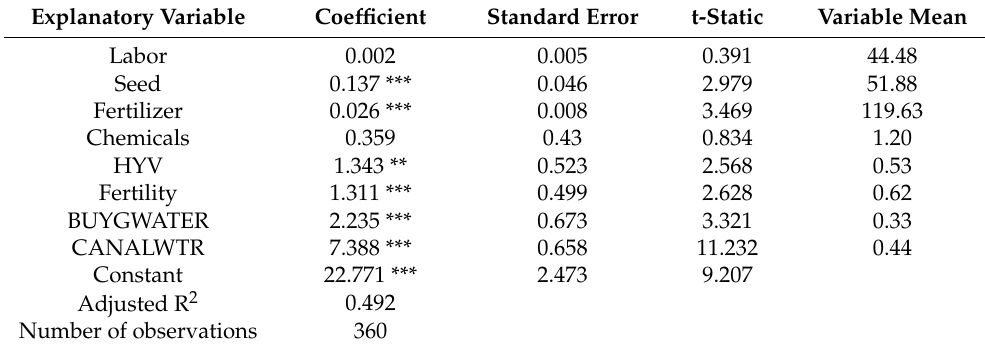
Table 6. Effect of sources of irrigation on plot-level yields in the study area.